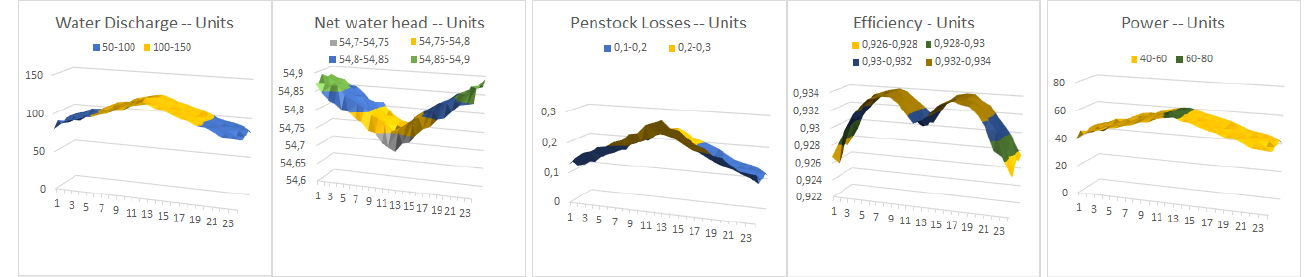
Figure 6. CRO with Gaussian Mutation— CRO ( 4 ) . Results of Water discharge (m 3 /s). Net water head (m). Penstock (m). Efficiency (%) and Power generated (MW/h). Daily dispatch (24